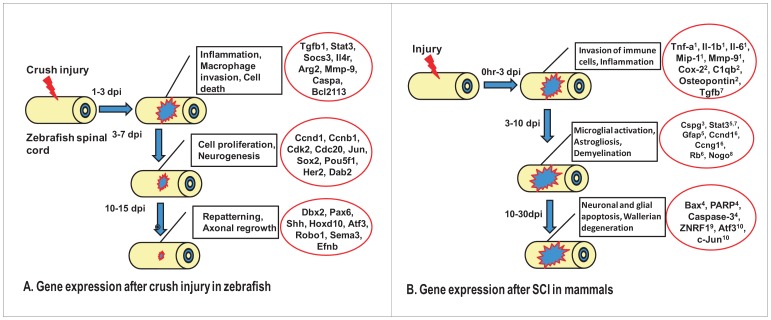
Comparative analysis of cellular events and upregulation of genes following SCI in zebrafish and mammals.A) Schematic representation of different events and underlying expression of some important genes during zebrafish spinal cord regeneration. B) Schematic representation of different events and corresponding upregulation of genes in mammalian spinal cord after inflicting different modes of injury. The expressions of gene(s) are compiled based on previous evidences, which are known to regulate different cellular events. (1. [120]; 2. [121]; 3. [122]; 4. [123]; 5. [111]; 6. [112]; 7. [124]; 8. [125]; 9. [126]; 10. [127].).